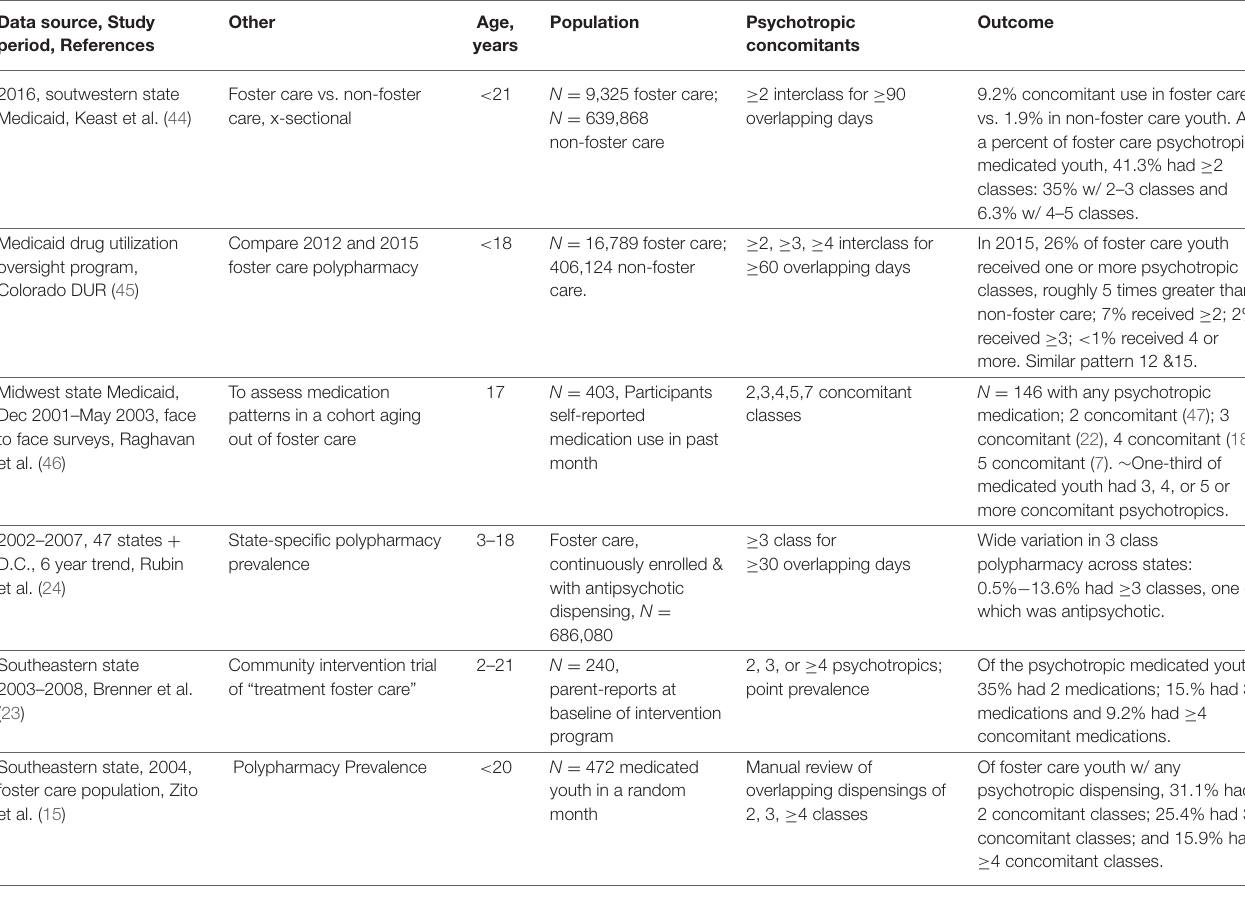
TABLE 5 | Pediatric psychotropic polypharmacy in the foster care population. Data source, Study period, References